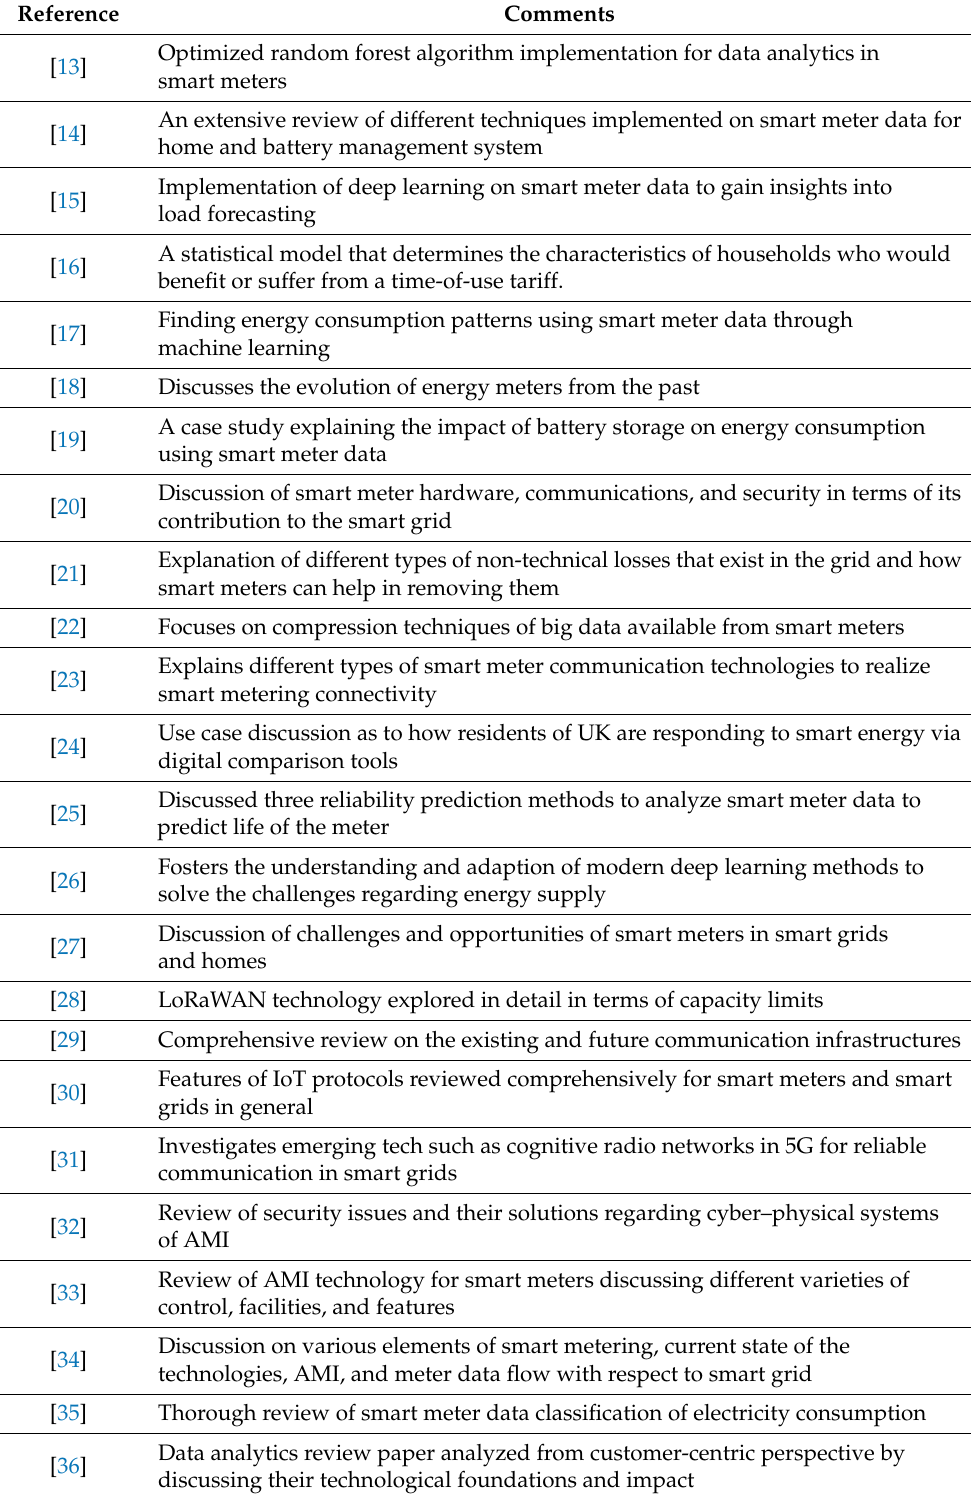
Table 1. Overview of different reviews and applications of smart